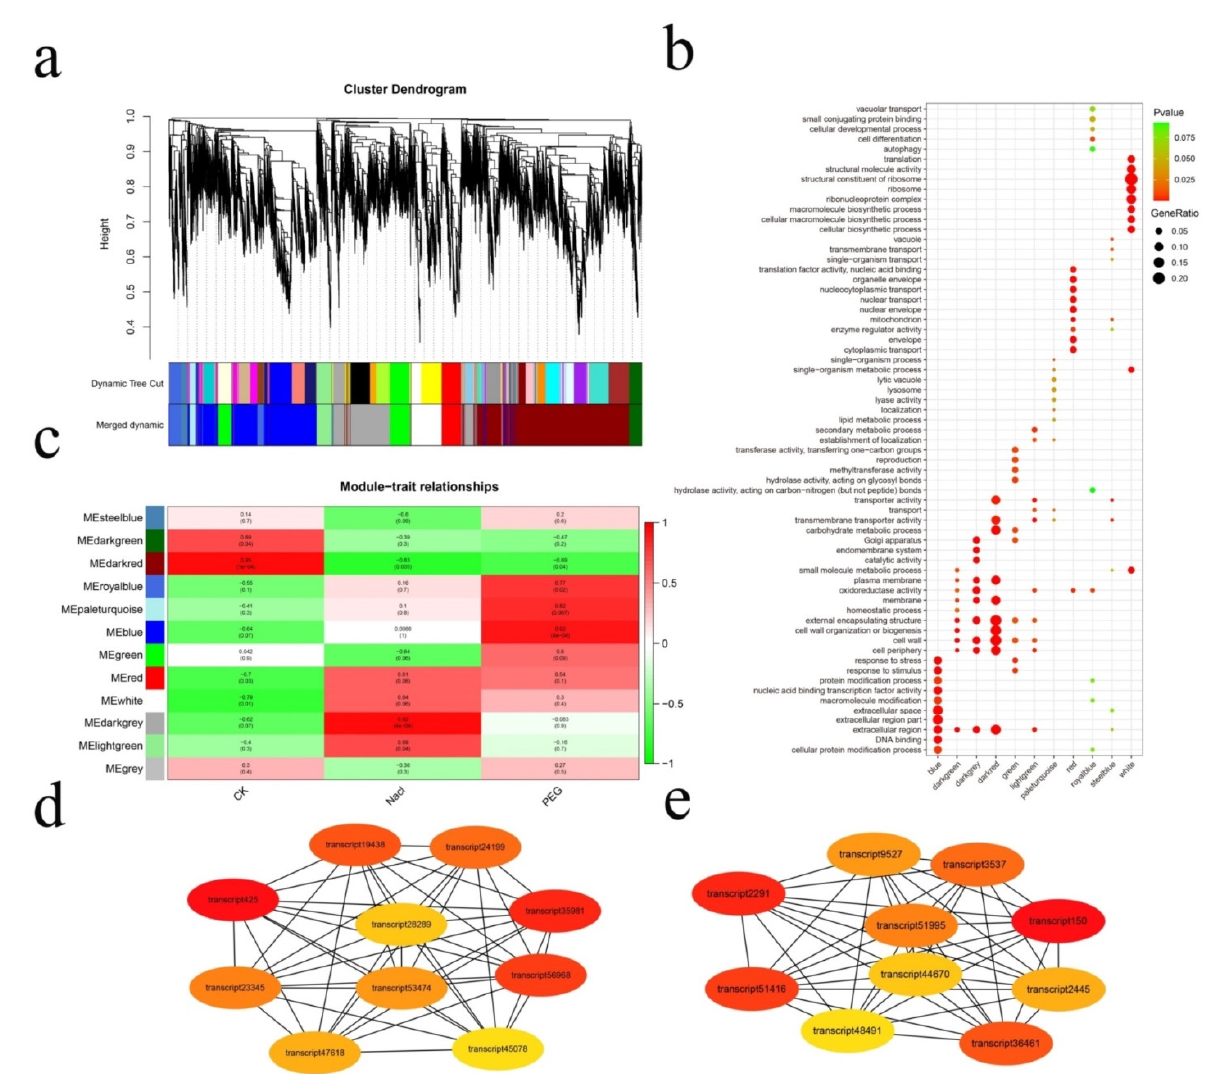
Figure 3. Construction of the gene co-expression network through weighted gene co-expression network analyses (WGCNA). ( a ) Gene dendrogram obtained by hierarchical clustering with the module color. A total of 12 distinct modules were identified. ( b ) Scatterplot of GO enrichment for different modules. The size and color of the dots represent the gene ratio and the range of the P-value, respectively. ( c ) Relationships of modules and different samples. Each row in the table corresponds to a module, and each column corresponds to a sample. ( d ) The 10 hub genes under NaCl stress. ( e ) The 10 hub genes under polyethylene glycol (PEG) stress.